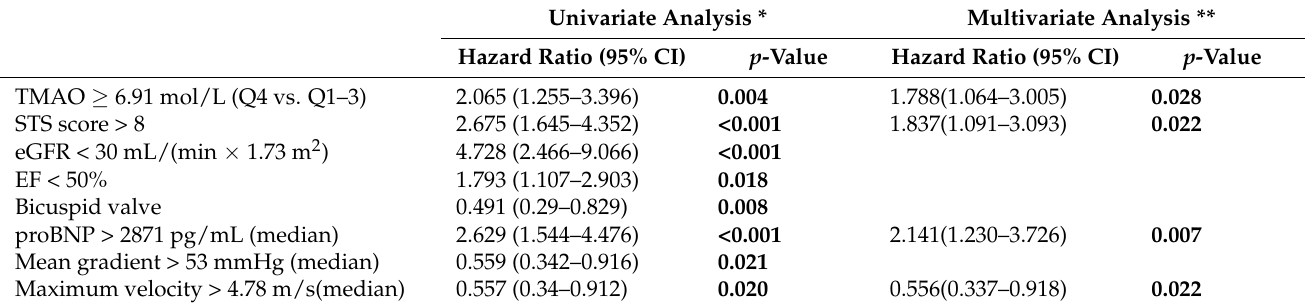
Table 4. Association with late cumulative all-cause mortality after TAVR (Cox regression